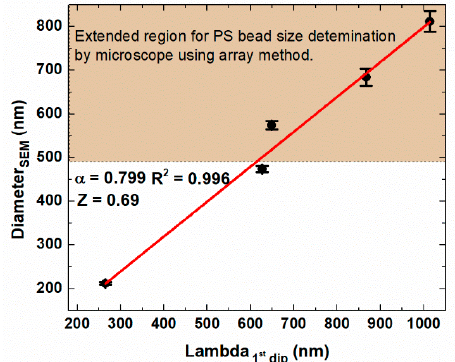
Figure 6. The diameters of the PS beads plotted against the spectral positions of the first dips. The Z parameter retrieved from the slope of the plot was Z = 0.69, which agrees well with the theoretical value Z = 0.7 used for finite-di ff erence time-domain (FDTD)